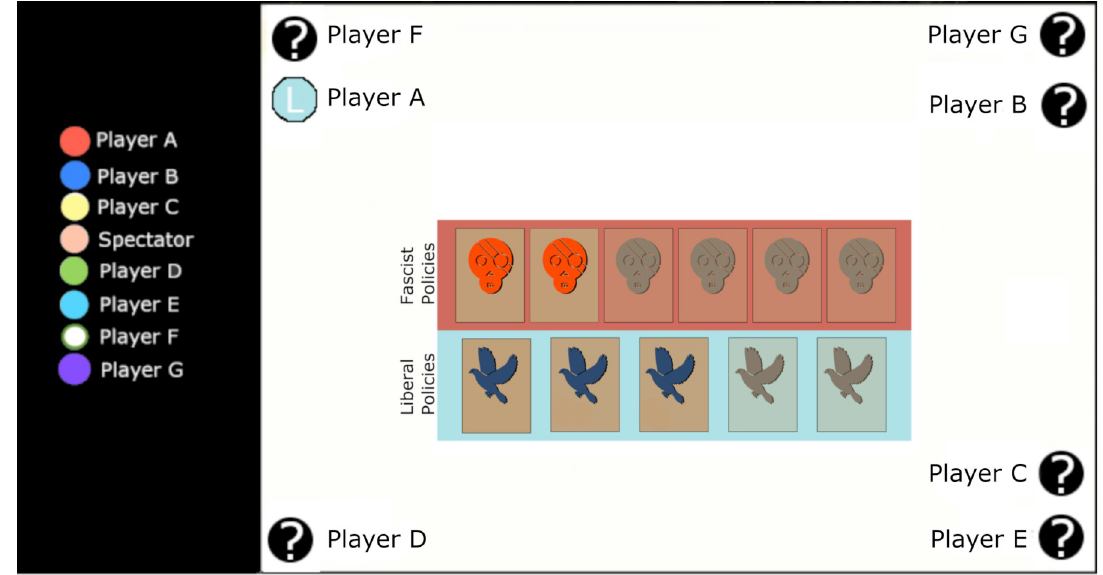
Fig 1. Schematic of Communications (left) and game (right) interfaces as viewed from the perspective of Player A. This participant was playing as a Liberal (blue team) who does not know the roles of any other player. A visual cue (green circle) indicates that Player F is presently speaking. In the scenario depicted, the Fascist team has passed 2 of the 6 policies they need to win, while the liberals have passed 3 of the 5 policies that they need to win.